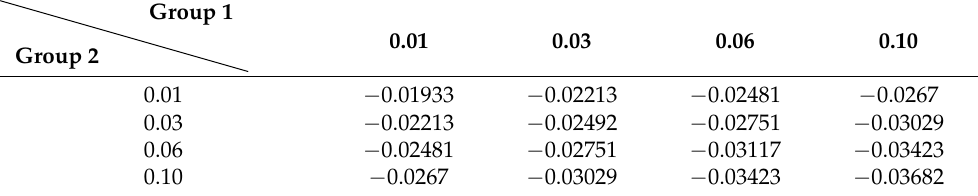
Table A5. Damping coefficient for TM3 of SG under different K p .